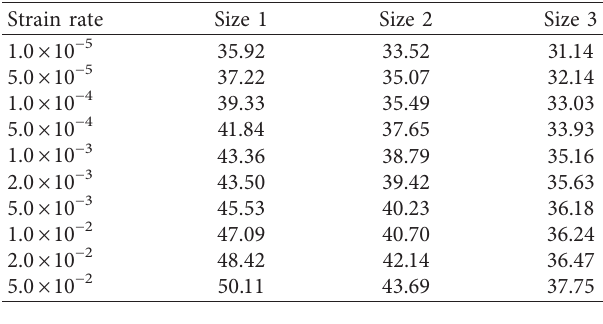
Figure 6: The failure mode under size effect (1.0 × 10 − 3 /s). (a) L � 70 mm. (b) L � 100mm. (c) L � 150mm. Table 2: The compressive strength characteristic values under different loading conditions